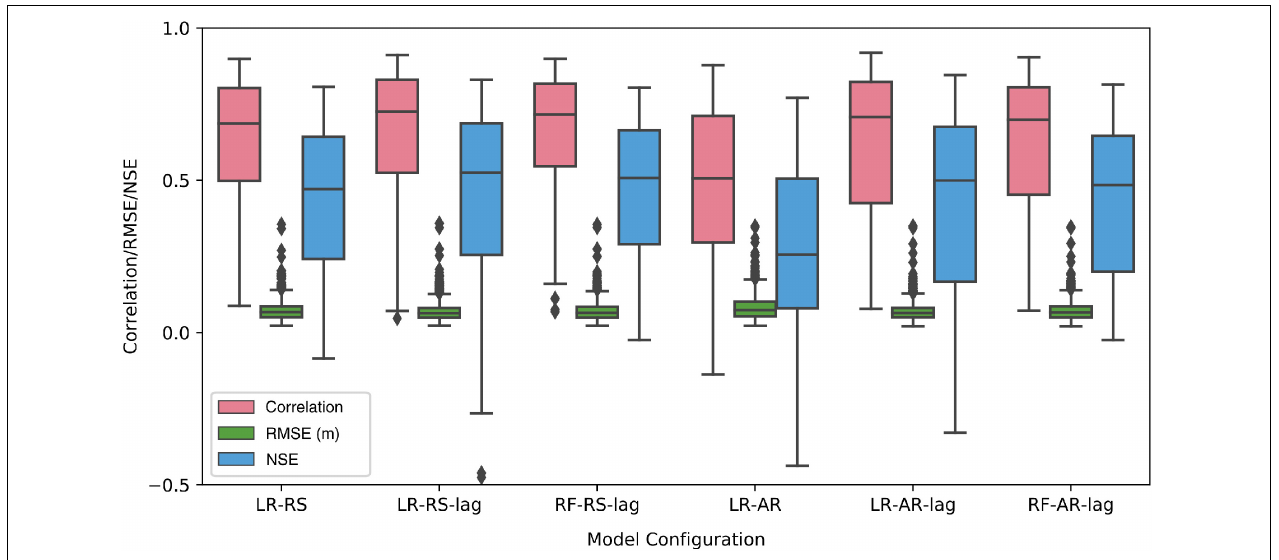
FIGURE 4 | Validation of the six model configurations (LR-RS, LR-RS-lag, RF-RS-lag, LR-AR, LR-AR-lag, and RF-AR-lag) in terms of correlation coefficient, RMSE, and NSE.